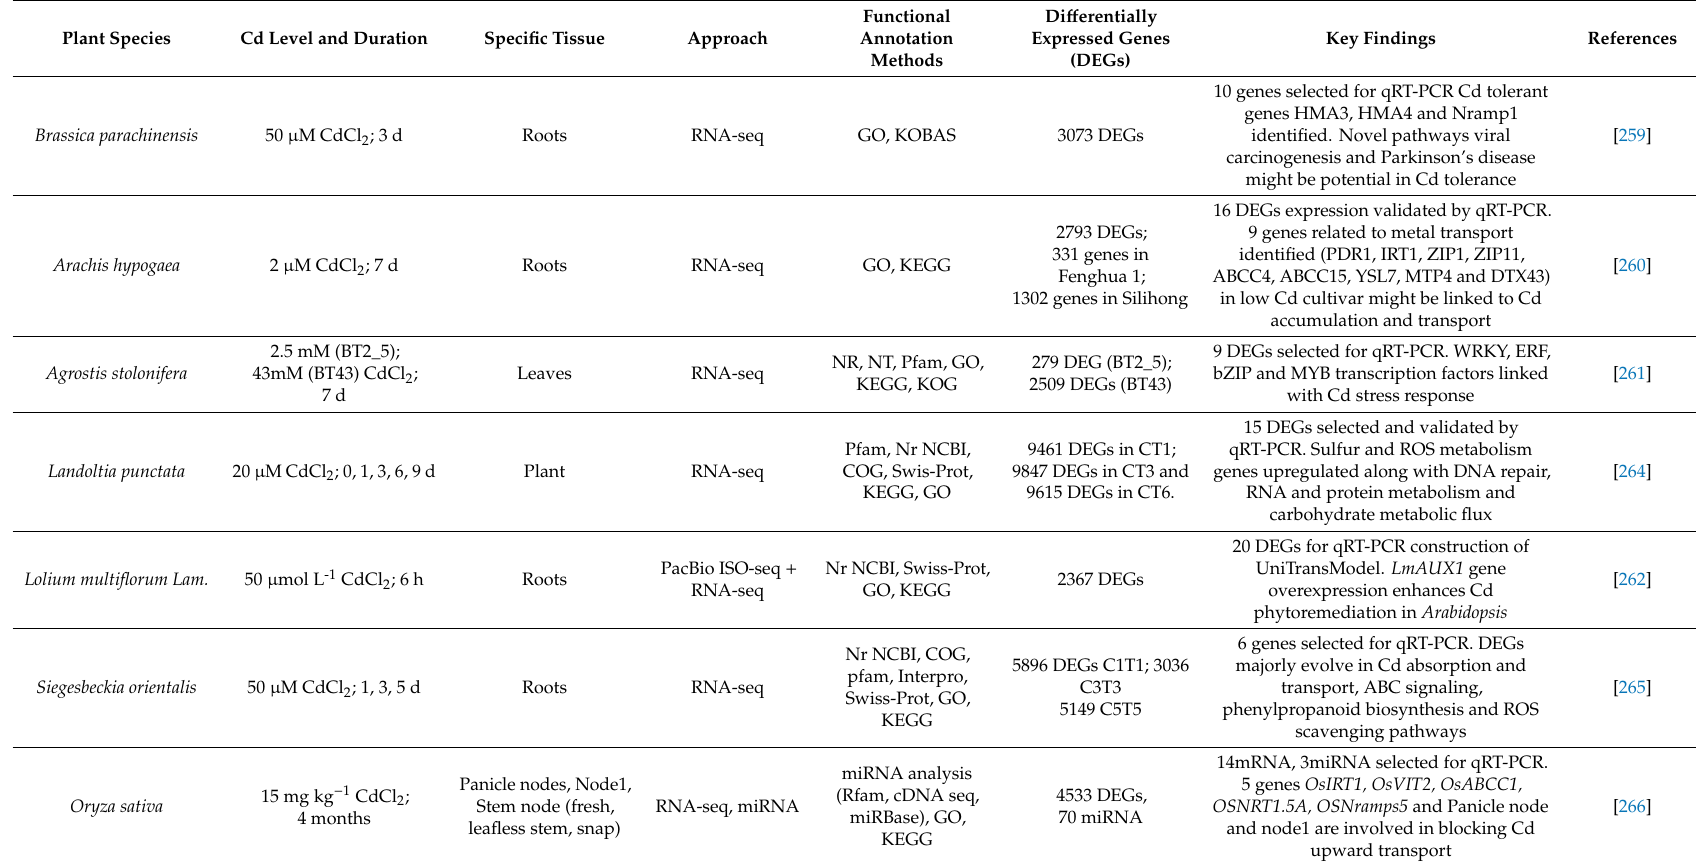
Table 4. Summary of experiments directed using transcriptomic approaches under Cd stress in